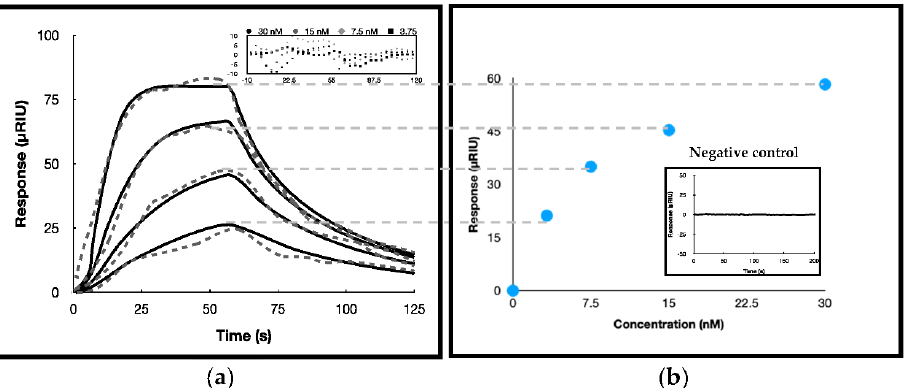
Figure 3 . ( a ) Binding kinetic fitting of experimental SPR sensorgrams (grey dashed lines) with corresponding Langmuir 1:1 ligand model simulation (black solid lines) for G4 and SUMO-muRif1- CTD interaction. Running buffer was 20 mM HEPES pH 7.4, 500 mM KCl, the association time was 60 s and flow rate in all the analyses was 100 μ L/min. SUMO-muRif1-CTD concentration was 3.75, 7.5, 15 and 30 from bottom to top. The inset indicates the residual plots for these analyses. ( b ) Steady- state fitting of the sensorgrams. The inset indicates the difference sensorgram of the control protein injected for checking the specificity of the sensorchip prepared.